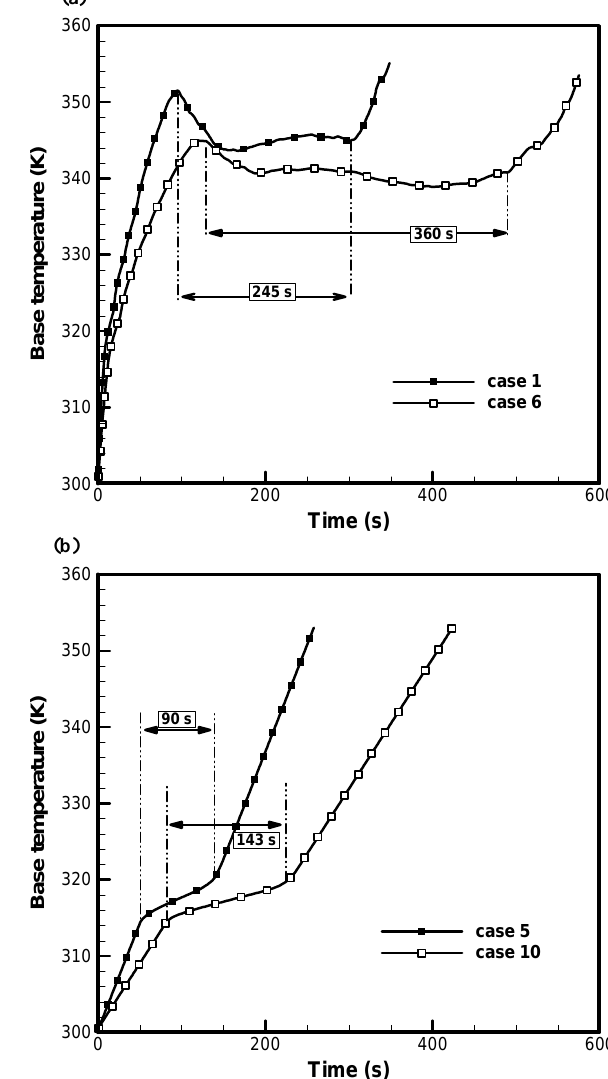
Figure 12. Base temperature evolution with time for different fin heights: (a) various cases for 25 fins and w F = 2mm and (b) various cases for 100 fins and w F =